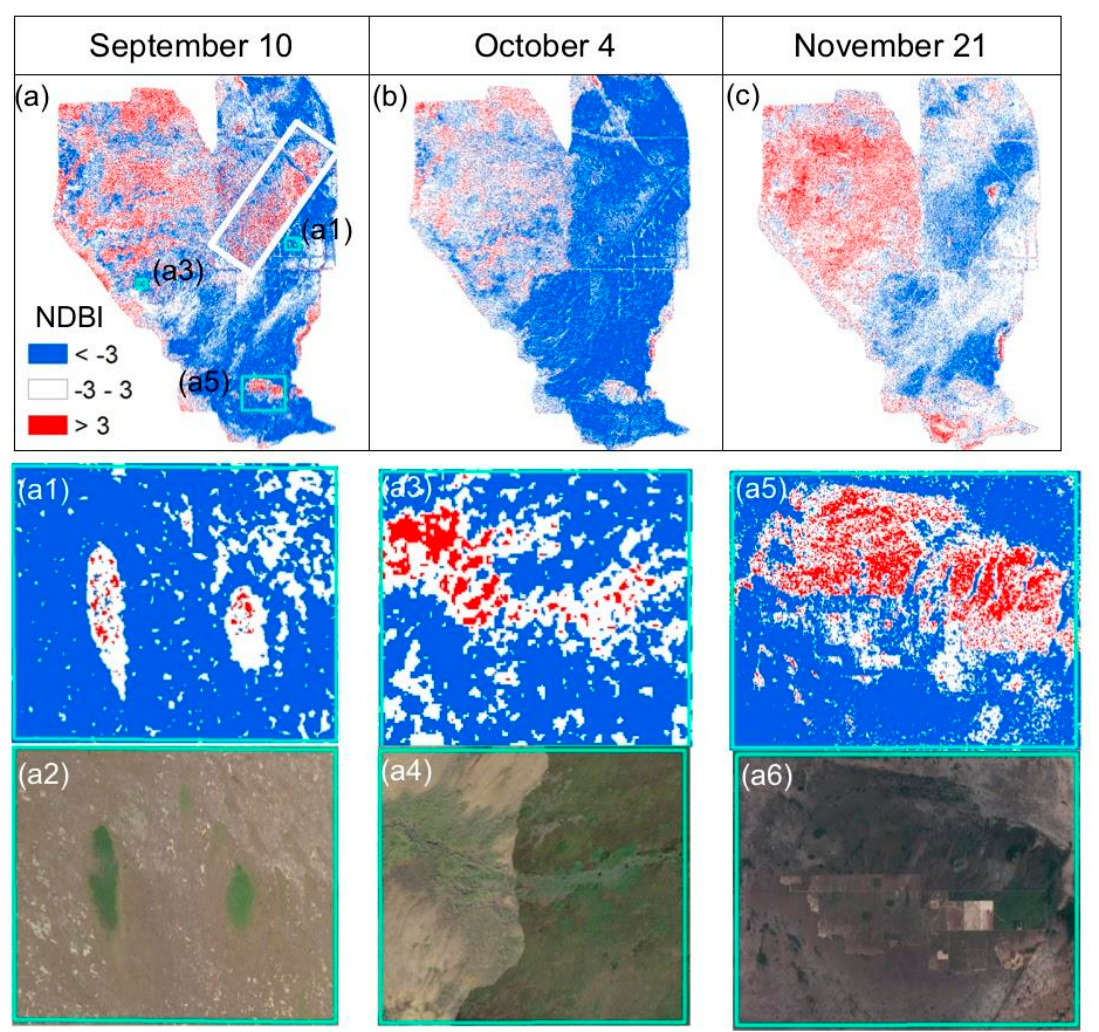
Figure 6. ( a ) NDBI map for the during-event (10 September) SAR acquisition with three cyan frames denoting local areas with a contrast NDBI pattern and a white frame denoting the boundary area between WCA-3A and 3B. ( b , c ) NDBI map for post-event SAR dates October 4 and November 21, respectively. ( a1 – a6 ) Zoomed-in views of three exemplary areas with ( a1 , a3 , a5 ) displaying classified NDBI values and ( a2 , a4 , a6 ) displaying the corresponding optical images. The figures are similar to the results reported in our previous study